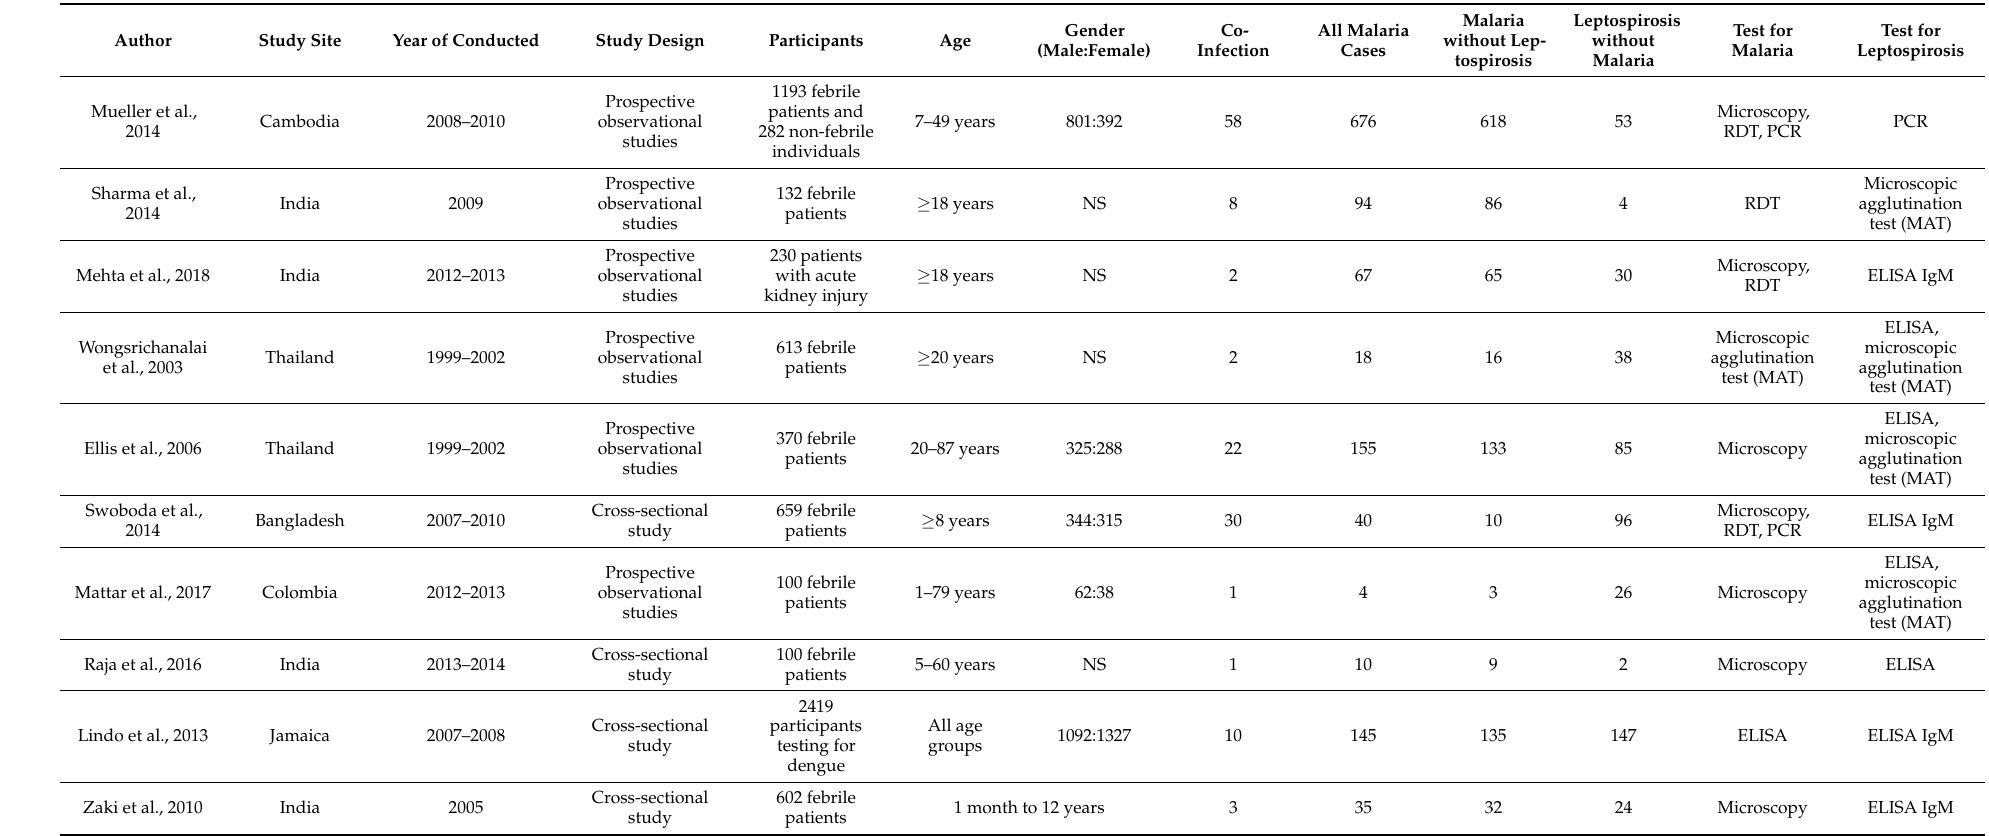
Table 1. Characteristics of the included